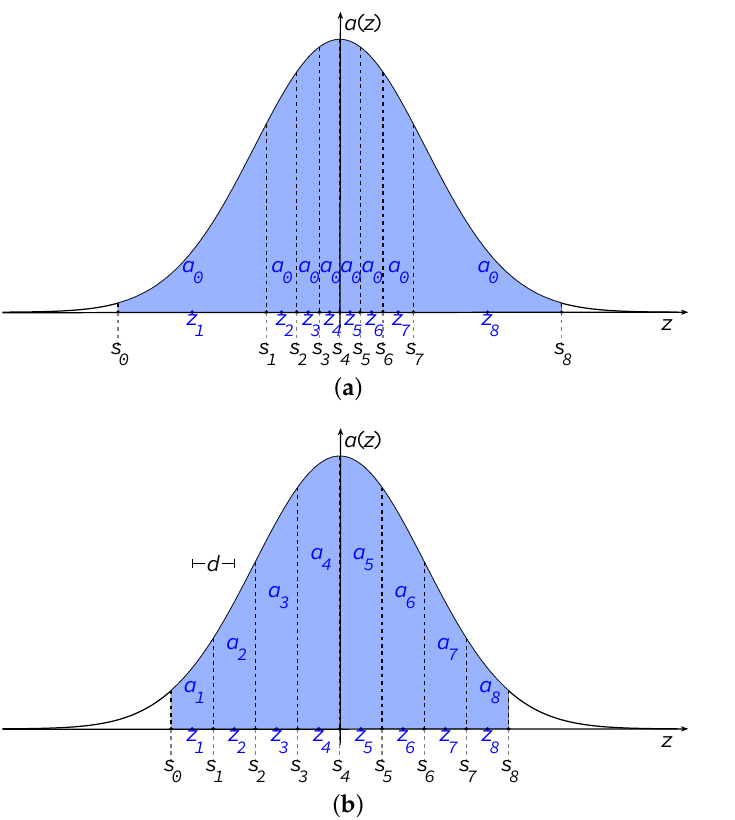
Figure 2. ( a ) Position synthesis (PS): the interval extrema s n are evaluated by imposing the equi-area requirement of the density tapering approach. The final positions z n are the middle points of each interval. ( b ) Excitation synthesis (ES): each element excitation a n is evaluated as the area between the z -axis and the graph of a ( z ) in the interval [ z n − d /2, z n + d /2 ]